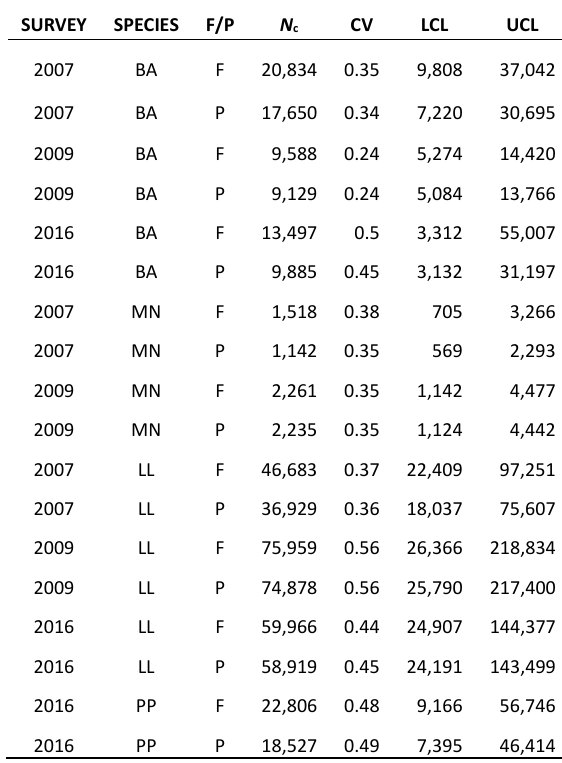
Table 2. Abundance estimates ( N c ) for the full (F) and post-stratified (P) survey area by survey year and species. Estimates are fully corrected for common minke whales and corrected for perception bias only for other species. BA – common minke whale; LL – white-beaked dolphin; MN – humpback whale; PP – harbour